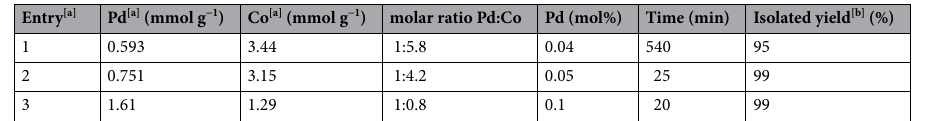
Table 2. Mizoroki–Heck reaction between iodobenzene and n-butyl acrylate catalyzed by γ-Fe 2 O 3 @MBD/ Pd-Co containing different ratios of Pd:Co in water. [a] Based on ICP-OES analysis, [b] Reaction